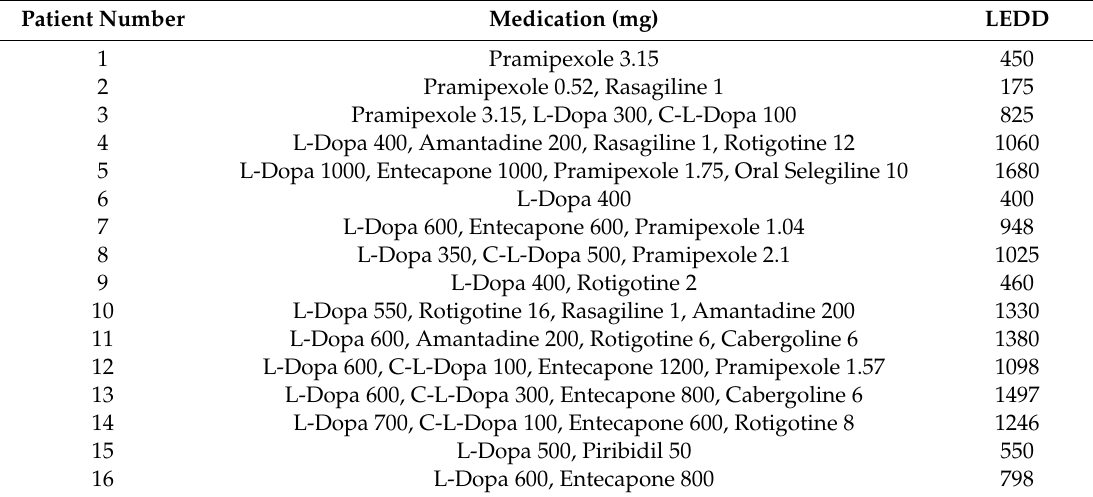
Table A2. Parkinson’s disease patients’ medication and LEDD scores.